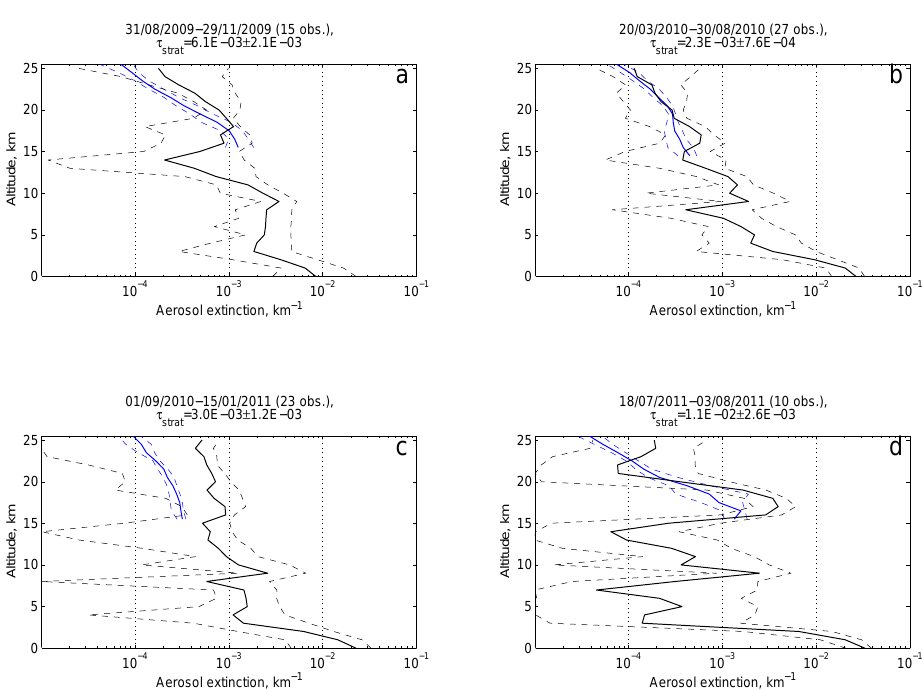
Fig. 11. The dashed lines and the solid line are 15.87th, 84.13th and 50th percentiles correspondingly for the ensembles of retrieved aerosol extinction profiles (black) and OSIRIS aerosol extinction profiles (blue). The period of data acquisition, number of observations and corre- sponding average stratospheric aerosol optical depths are indicated above the